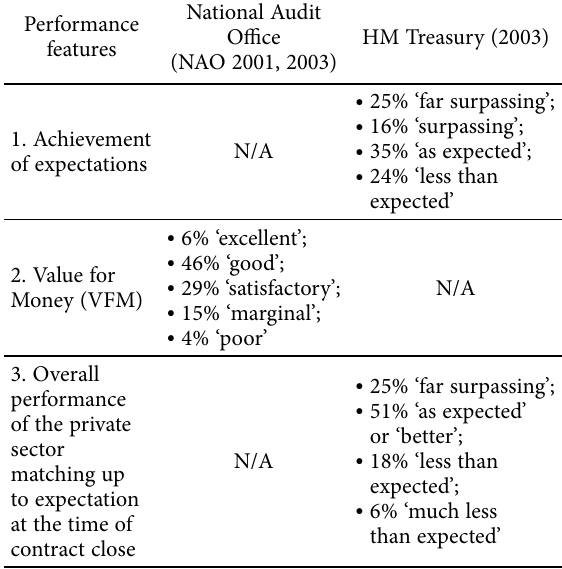
Table 3. PFI Operational Performance in the